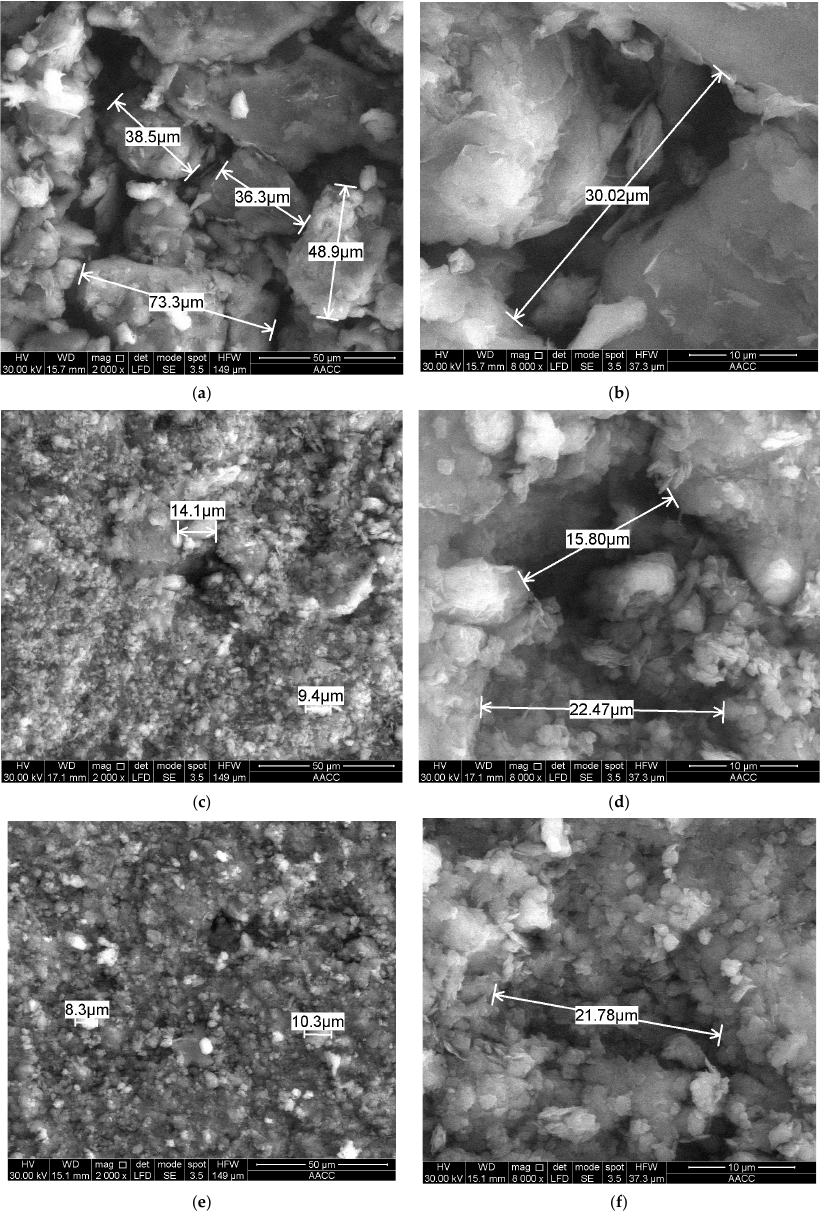
Figure 8. Scanning electron microscopy of rock under natural moisture content. ( a ) Sandstone (2000× magnification); ( b ) Sandstone (8000× magnification); ( c ) Sandy mudstone (2000× magnification); ( d ) Sandy mudstone (8000× magnification); ( e ) Mudstone (2000× magnification); ( f ) Mudstone (8000× magnification). The content of clay minerals in the sandstone was small, its structure was loose, and it had many internal pores. However, the mudstone had high clay mineral content and a dense internal structure, which may be the main factors leading to the low permeability and strong water isolation performance of mudstone. Due to the loose structure and voids